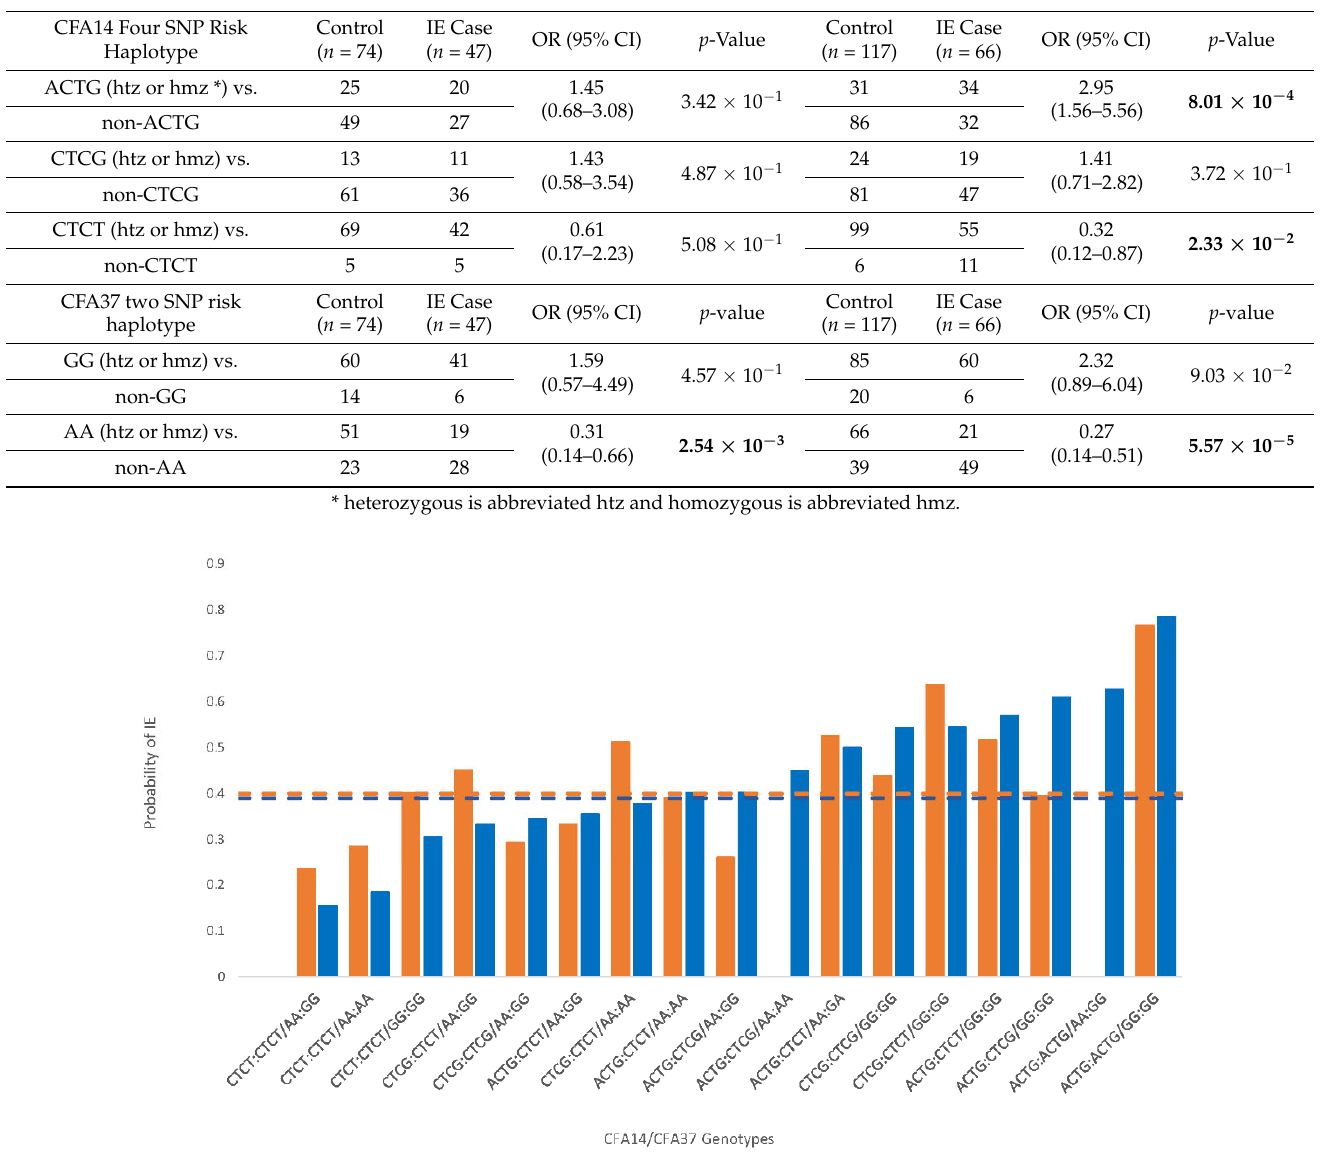
Figure 1. Canine chromosome 14 and 37 haplotype interactions and the probability of idiopathic epilepsy in the Belgian shepherd (BS) as a function of specific genotypic interactions. The orange bars represent the data from only the new cohort in the present study ( n = 121), while the blue bars reflect the combined data for the new cohort and the published [1] cohort of BS dogs ( n = 183). The dashed lines indicate the computed threshold (0.40 for orange and 0.39 for blue), with probabilities in excess of the lines indicating a significantly increased risk of IE. Table 2. Frequency of canine chromosome 14 (CFA14) 4 ‐ SNP haplotypes associated with idio ‐ pathic epilepsy risk in the Belgian shepherd compared to other breeds.